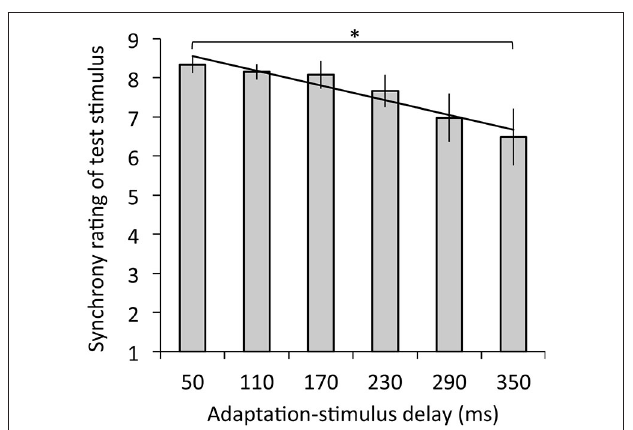
FIGURE 3 | Synchrony ratings for test stimulus with the 50-ms delay in relation to mean ratings as a function of adaptation-stimulus delay with a significant regression line . A higher rating means a stronger subjective synchrony between participants’ hand action and the hand image. Error bars denote ± 1 standard error of the mean. Asterisk indicates a significant difference between conditions (* p < 0.05).